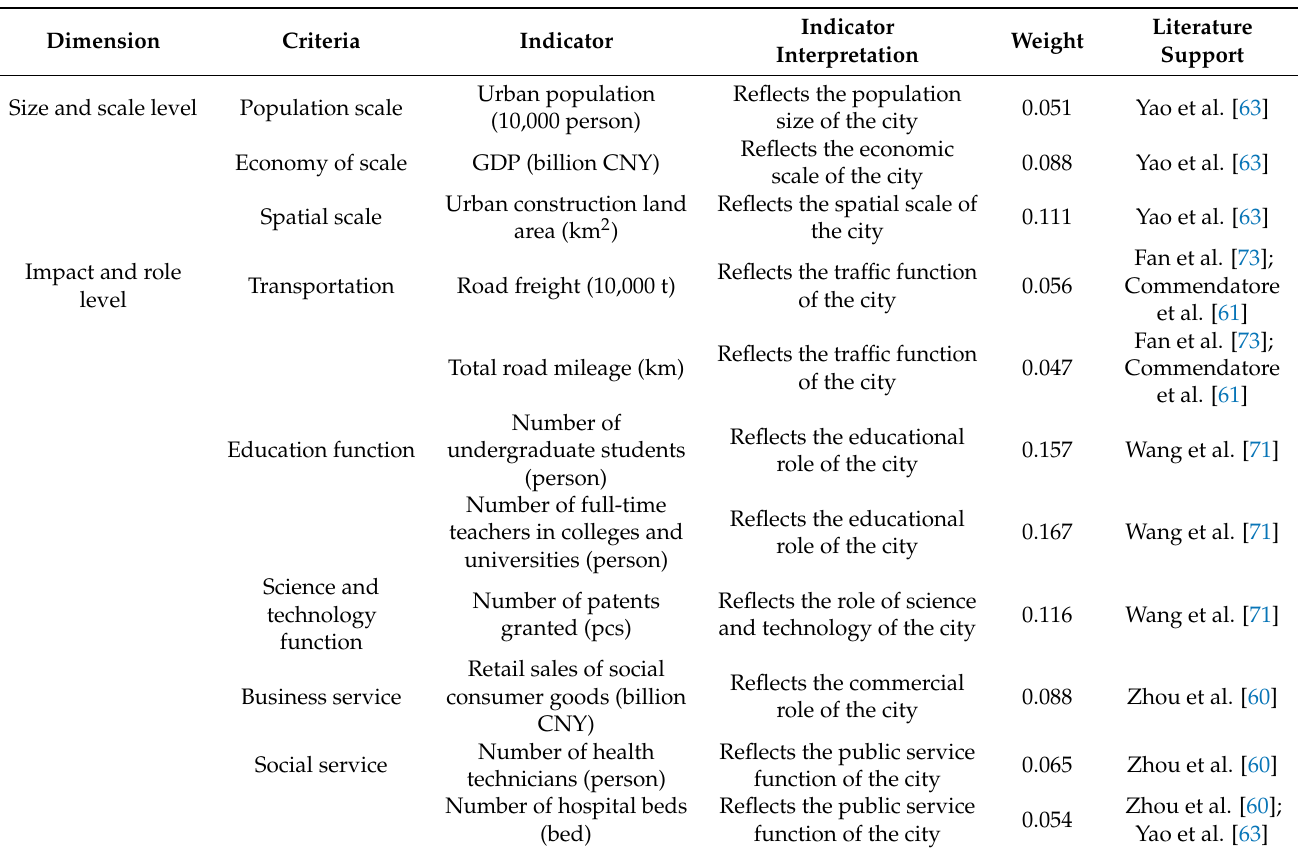
Table 2. Evaluation index system of urban hierarchy level